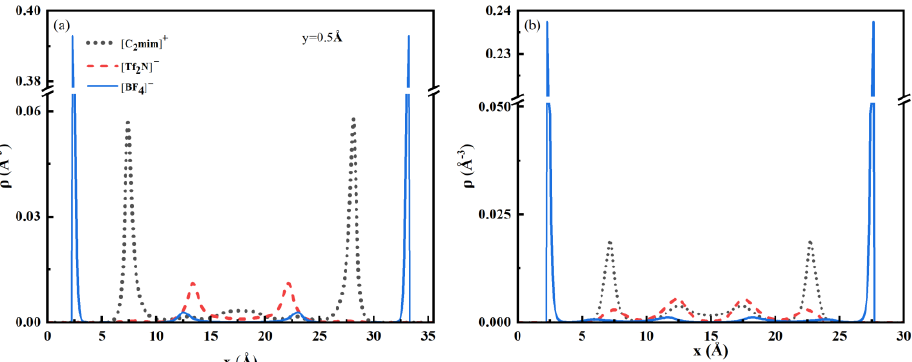
Figure 4. ( a ) One-dimensional density curves of ions taken at the specified y position. Other conditions are the same as in Figure 3. ( b ) Density profiles for ions in a smooth pore at surface potential 𝜙 𝑠 = 1 𝑉 , and X BF4 = 0.2.